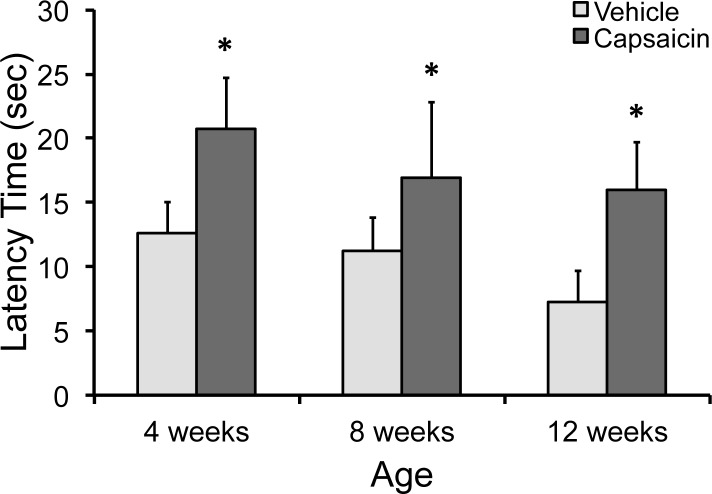
Hot-plate test of thermal analgesia.Hot-plate analgesia testing of vehicle- and capsaicin-treated mice was performed at 4, 8, and 12 weeks of age to verify decreased peripheral sensory nerve function prior to tibial compression. Capsaicin-treated mice exhibited significantly longer latency times than vehicle-treated mice at all time points when exposed to a constant 55°C thermal stimulus, indicating decreased thermal sensitivity. * indicates significant differences between capsaicin- and vehicle-treated mice (p < 0.05).